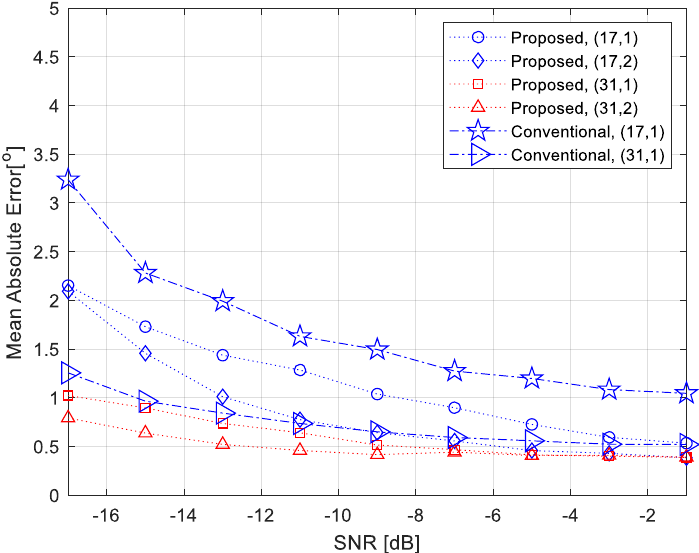
Figure 4. The performance of AoD estimation when the conventional and proposed methods are used (3 BSs, Rician, K = 15 dB, 1 RF).